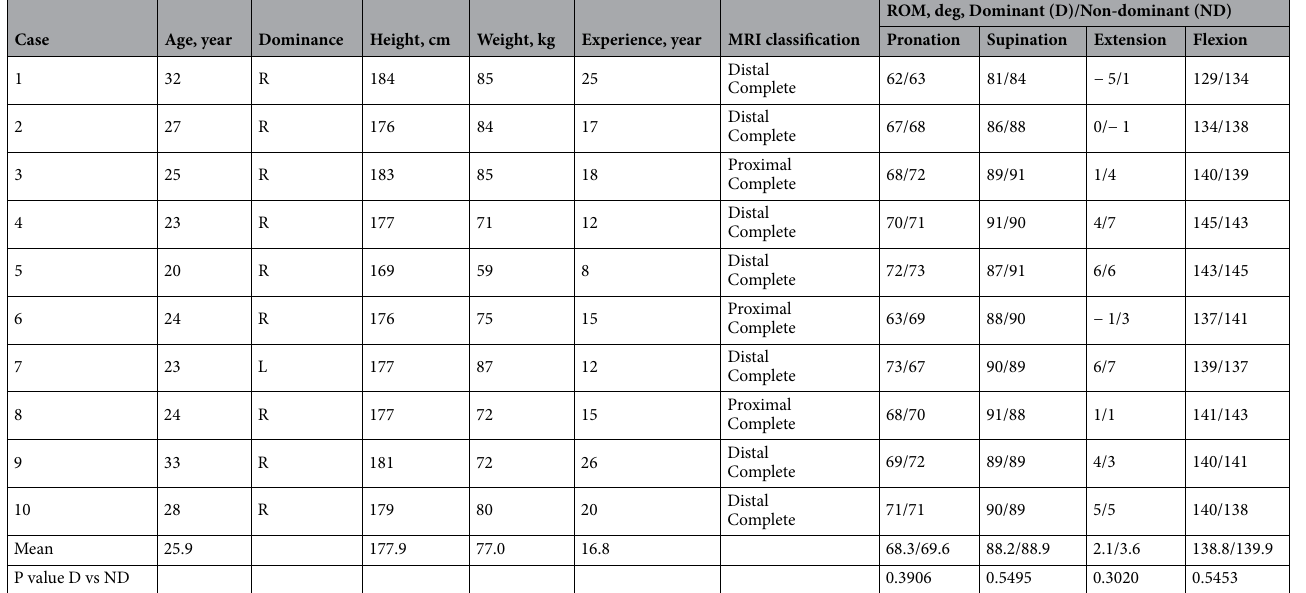
Table 1. Participants’ characteristics.